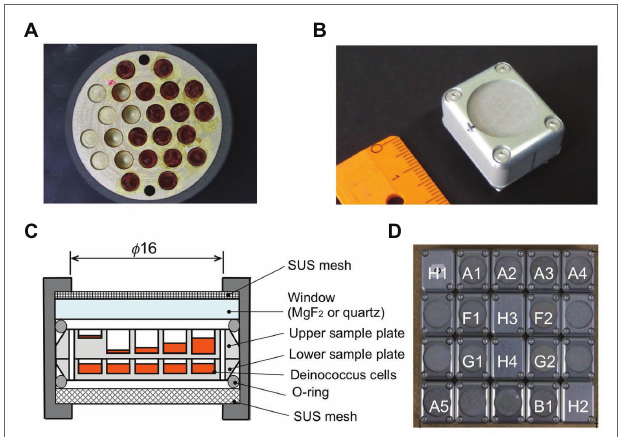
FIGURE 1 | Experimental tools in the Tanpopo mission. (A) Sample plate (18 mm in diameter) with wells (2 mm in diameter) filled with deinococcal cells. Image (B) and cross-section (C) of an exposure unit. A metal mesh was placed at the top of the window to prevent scattering of accidentally broken windows. Wells of the upper sample plate were filled with deinococcal cells to different depths. The lower sample plate contained the dark control samples (modified from Kawaguchi et al., 2016). (D) Each exposure panel was comprised of 20 exposure units (modified from Kawaguchi et al., 2016). A1–A4: D. radioduras wild type R1 and mutant strains KH311, rec30, and UVS78, under MgF 2 window. A5: D. aerius TR0125 under MgF 2 window. B1: D. radioduras R1 under quartz window. F1 and F2: Alanine VUV dosimeter under MgF 2 window. G1 and G2: Alanine VUV dosimeter under SiO 2 window. The windows of F2 and G2 were coated with Au neutral density filter. H1, H2, H3, and H4: Ionization radiation